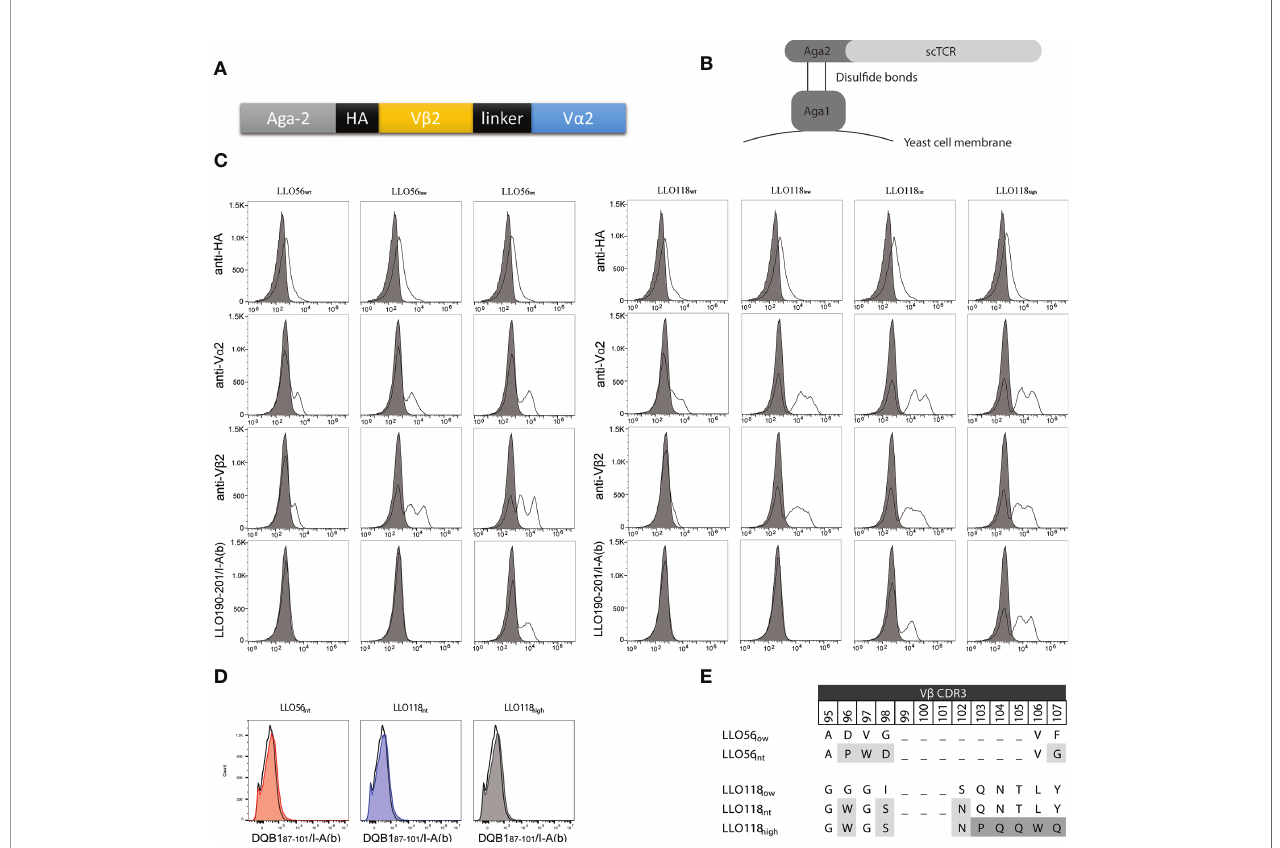
FIGURE 1 | LLO118 and LLO56 stability and af fi nity maturation by yeast display. (A) Schematic of single-chain TCR (scTCR) which includes TCR a and b variable domains (V a and V b ) spliced from TCR constant domains and connected with a 13 amino acid linker. Aga-2 is the yeast mating protein that displays the scTCR on yeast cell membrane. Each construct contains an HA tag for antibody detection. (B) Schematic of a scTCR displayed on the cell surface via yeast display. The yeast mating protein Aga1 binds to the Aga2-scTCR fusion protein and enables the display of these proteins on the cell surface. Large scTCR libraries can be generated, stained with antibodies or peptide-MHC tetramers, and yeast clones containing scTCRs with improved stability or af fi nity characteristics can be identi fi ed and selected. (C) Wild type LLO118 and LLO56 were engineered for improved stability and higher af fi nity by yeast surface display. Clones with stability mutations were selected for using monoclonal anti-V a or anti-V b antibodies. The surface displayed constructs were then selected for improved af fi nity using the peptide MHC tetramer LLO 190-201 /I-A b . Staining of wild type clones LLO56 WT and LLO118 WT ( fi rst and fourth columns), stability clones LLO56 low and LLO118 low (second and fi fth columns), intermediate af fi nity clones LLO56 int and LLO118 int (third and sixth columns) and high af fi nity clone LLO118 high (seventh column) is shown. Stains include antibodies against the HA epitope ( fi rst row), V a 2 (second row), and V b 2 (third row), or LLO 190-201 /I-A b pMHCII tetramer (fourth row). Gray- fi lled histogram represents cells-only control. Histograms are representative of n >3 experiments. (D) Af fi nity clones were incubated with saturating amounts of non-target tetramer (DQB1 87-101 / I-A b ). Histograms compare cells only (black clear) with af fi nity clones (colored, shaded). (E) V b 2 CDR3 mutations that confer increases in af fi nity. CDR3 b regions are hypervariable; therefore, gaps mark the length of other known V b 2 CDR3 b regions. First round of af fi nity selection (light gray) for all af fi nity clones while second round of af fi nity selection (dark gray) applies only to LLO118 high